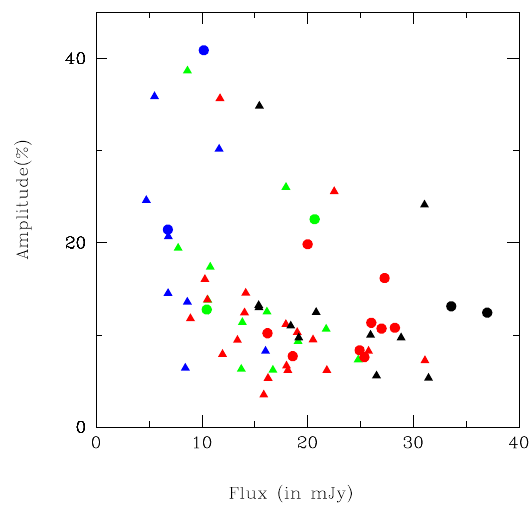
Figure 4. Amplitude of variability versus flux. Again, blue, green, red and black colors represent B, V, R and I bands, respectively, triangles give data from [19] and circles provide these new data. The Spearman correlation coefficient is − 0.42 with p >